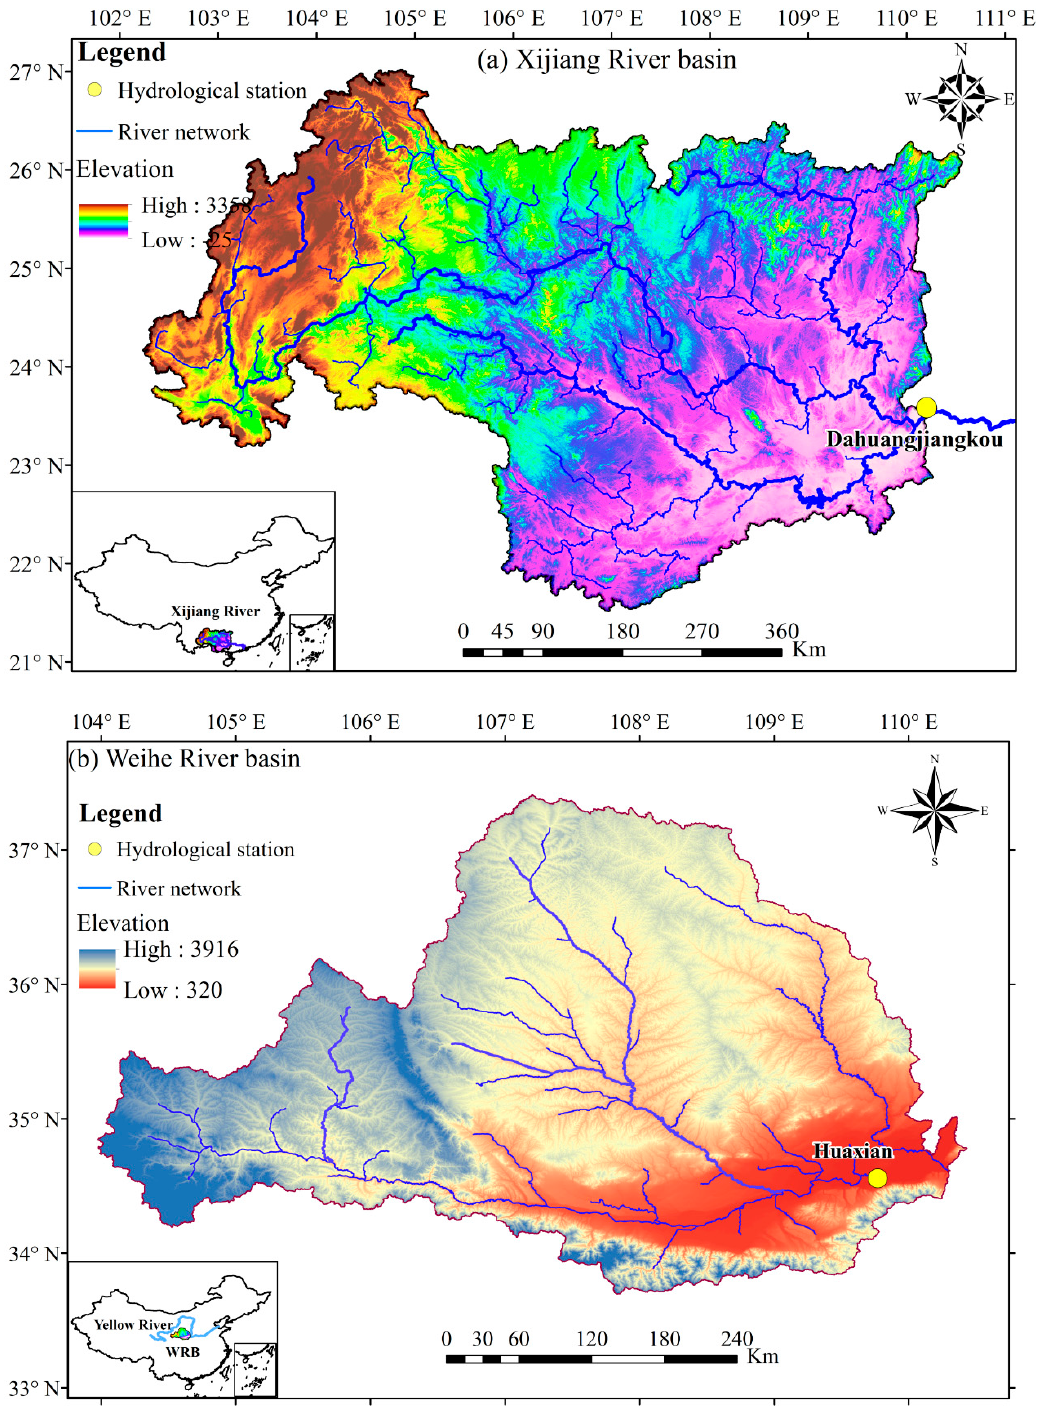
Figure 1. Location maps of the hydrological stations of ( a ) Xijiang River baisn and ( b ) Weihe River Basin.